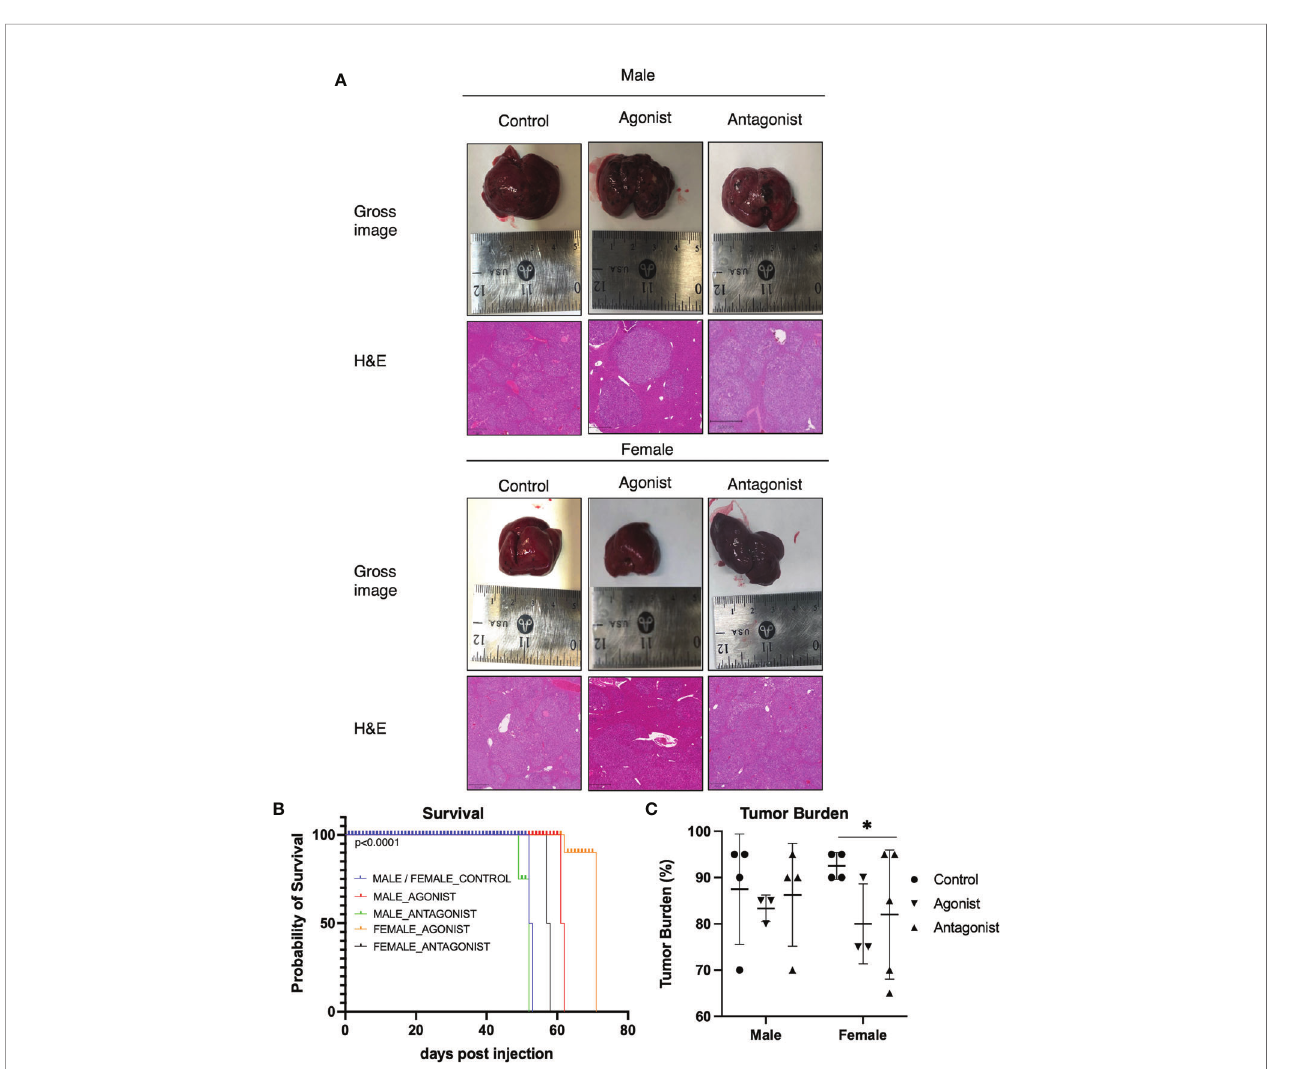
FIGURE 2 | ER- a agonist exposure improves survival and decreases tumor burden (A) Gross images of livers from mice upon sacri fi ce show notable macroscopic disease in all groups. H&E staining of representative liver sections from the three groups in both male and female mice. Control group livers show more malignant nodules in fi ltrating the tissue. The agonist groups have smaller foci of tumor nodules (Magni fi cation: 100X). (B) Kaplan-Meier curve comparing survival of HCC control mice (N = 4) and mice injected with ER- a agonist (N=6) or antagonist (N = 6). Agonist mice show signi fi cantly increased survival as compared to the control groups. p < 0.0001, Gehan-Breslow-Wilcoxon test. (C) Bar plot depicting tumor burden expressed as percentage of tumor cells in the liver tissue. Control groups livers show a higher percentage of in fi ltrating malignant cells. Mean with SD values are represented in the graph. *P < 0.05, multiple t-test. SD, standard